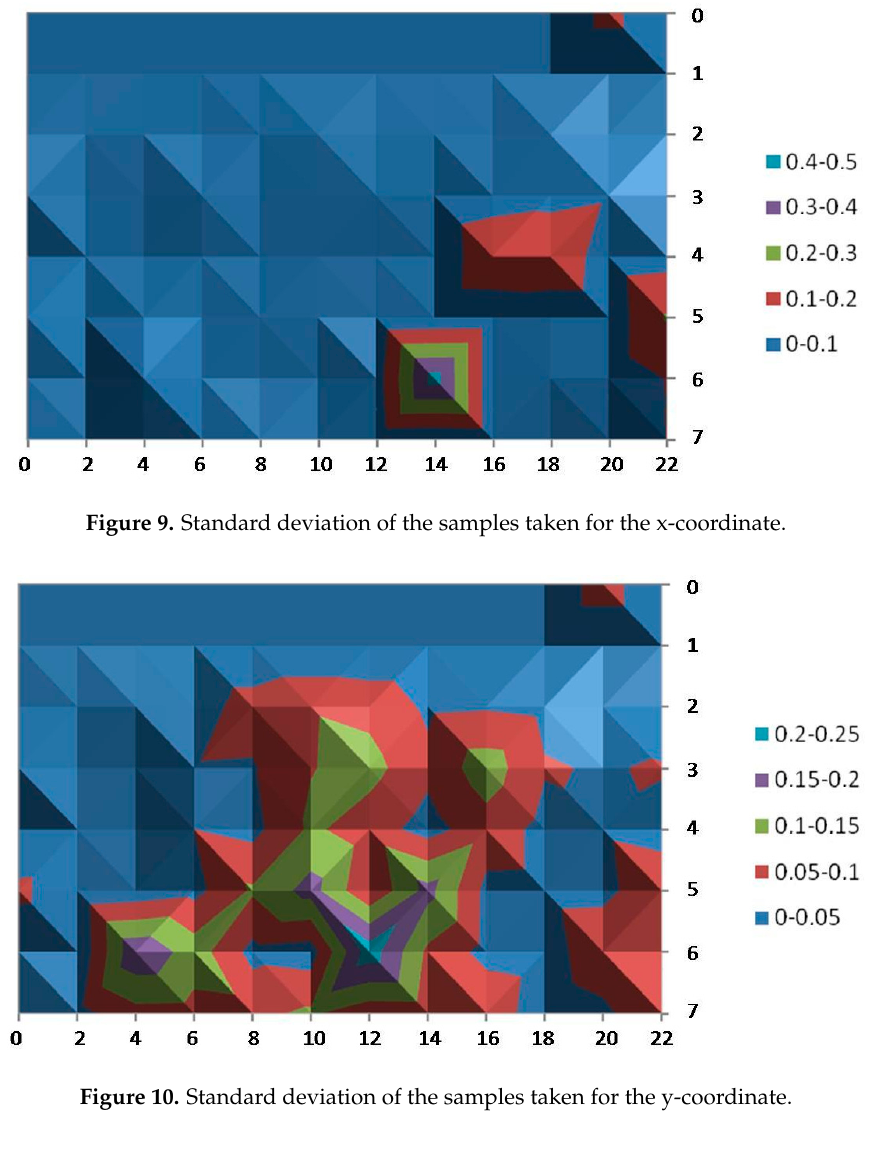
Figure 11. Office layout and points selected for measurements. Table 1. Average accuracy errors for one and two tags (in meters). Point in Room